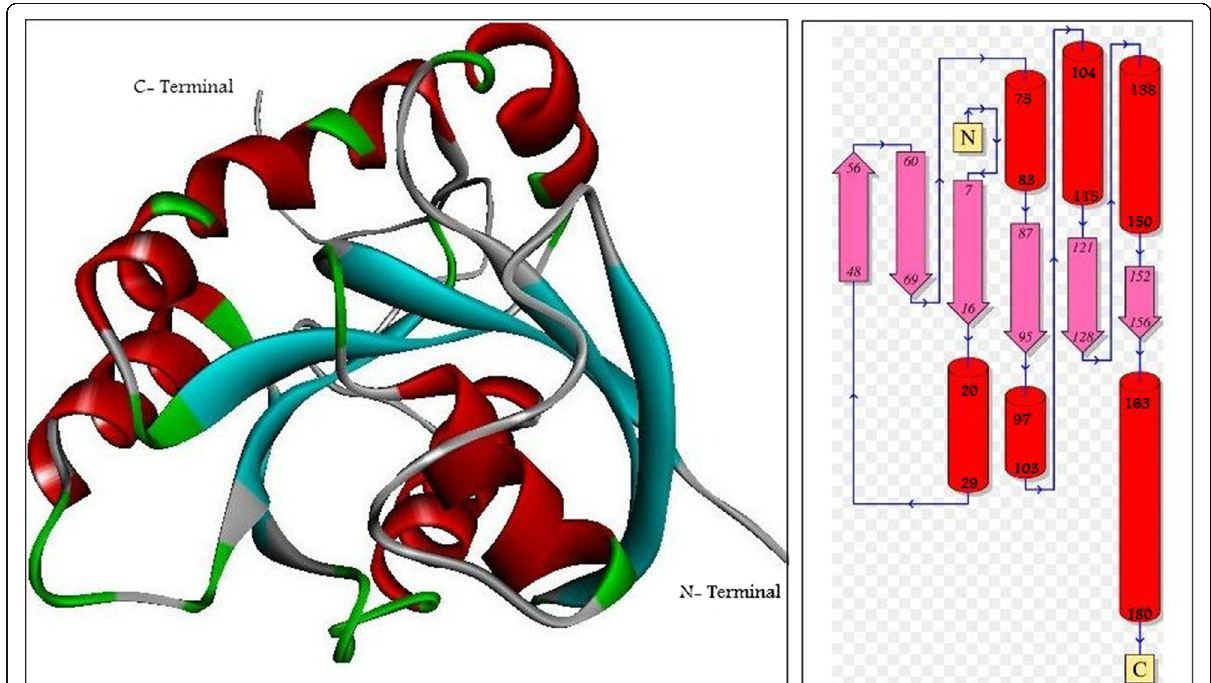
Fig. 5 Three-dimensional structure of Rab39a: The 3D structure of Rab39a has 6 α - helices and 6 β - sheets, obtained from Modeller 9.11